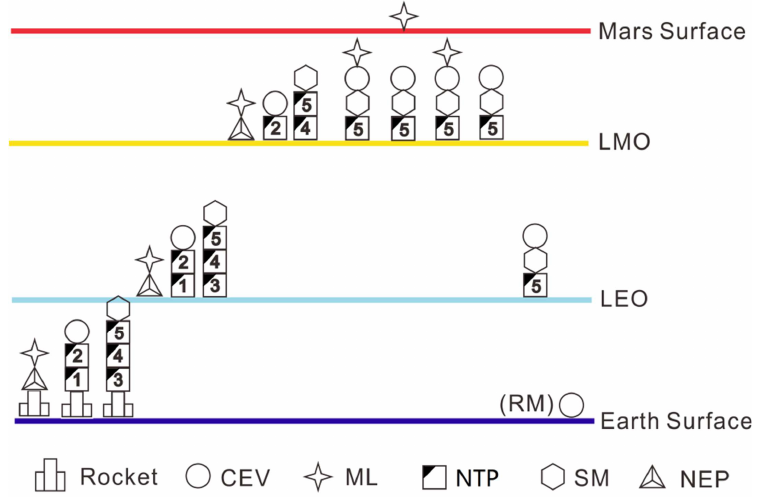
Figure 15. Schematic of Architecture-10. Table 19. Mission architecture matrix of